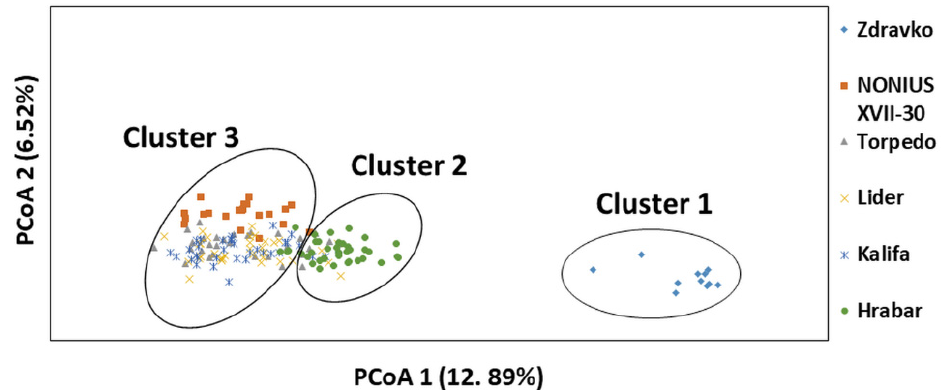
Figure 5. Population structure of six Danubian horse sire lineages genotyped with 15 microsatellites by means of principal coordinate analysis (PCoA), using GenAlEx 6.5 software. Principal Coordinates 1 and 2 were plotted for individuals (the shapes indicate which lineages they were from).